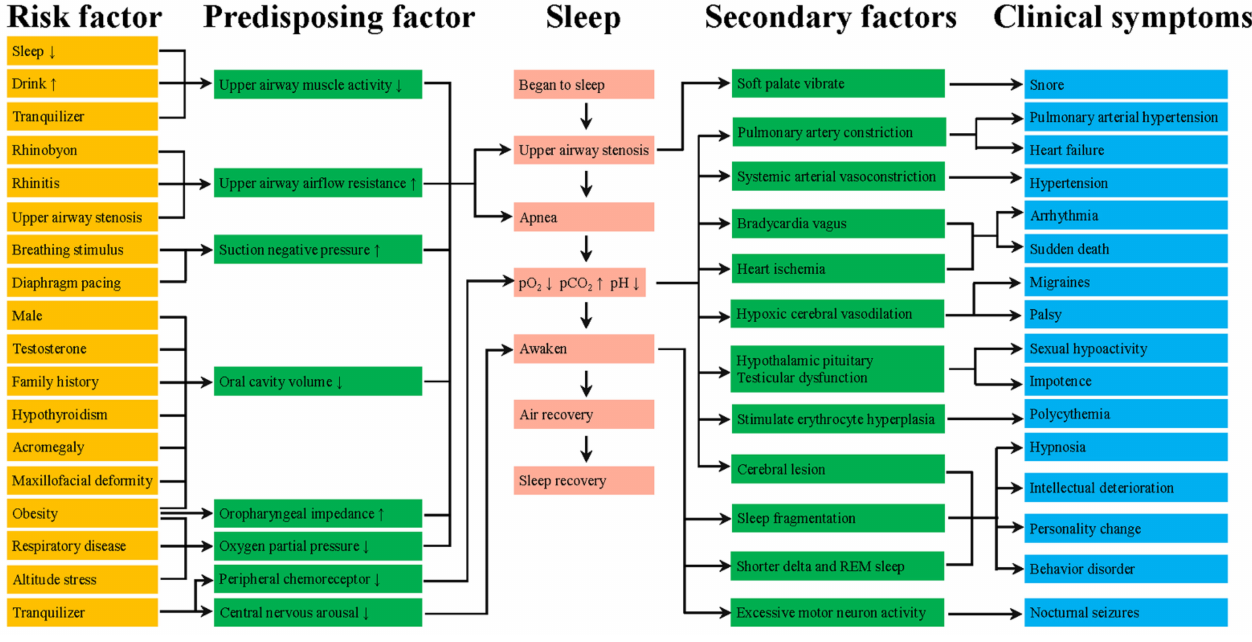
Figure 1. The pathogenesis of